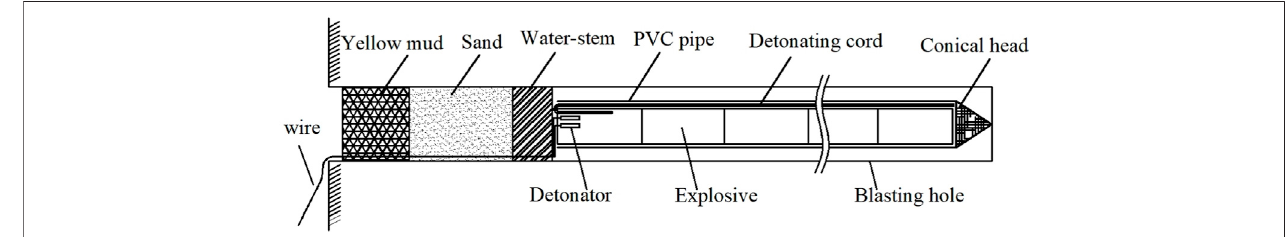
FIGURE 8 | Schematic diagram of controlled blasting charge structure.